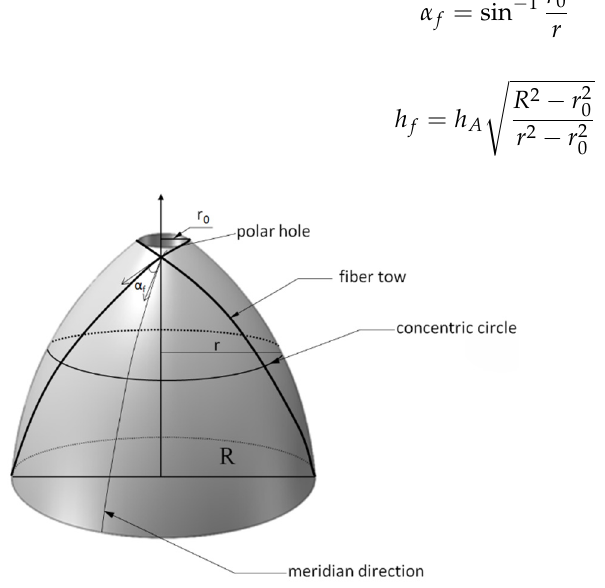
Figure 2. The dome section of the COPV.